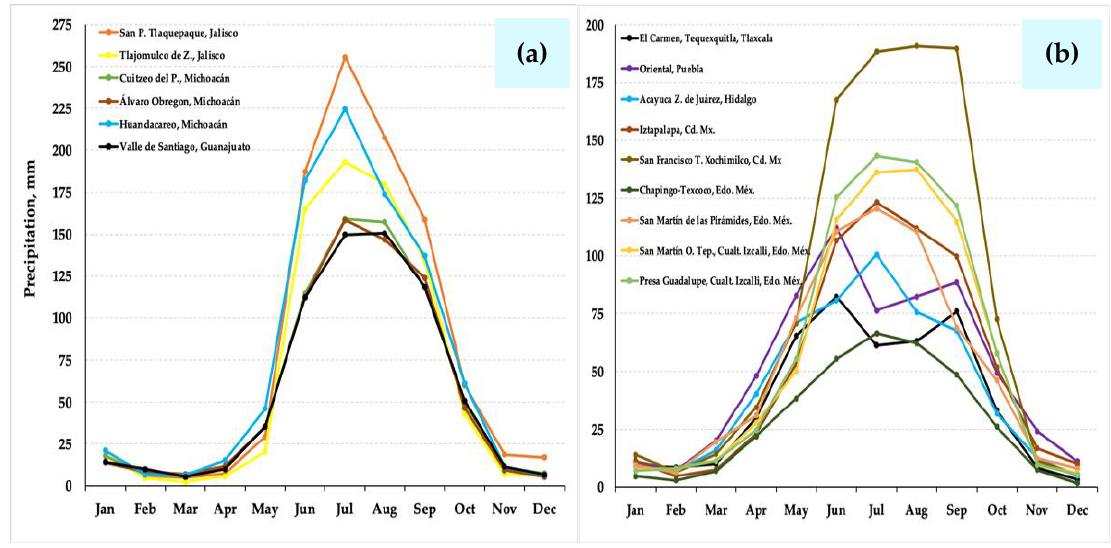
Figure 2. ( a ) Historical precipitation data from six stations in the western region of Mexico (Jalisco, Michoac á n, and Guanajuato); and ( b ) from nine stations in the Valley of Mexico and the central-eastern region of Mexico (Tlaxcala, Puebla, Hidalgo, Mexico City and Mexico State), where Suaeda edulis is reported.